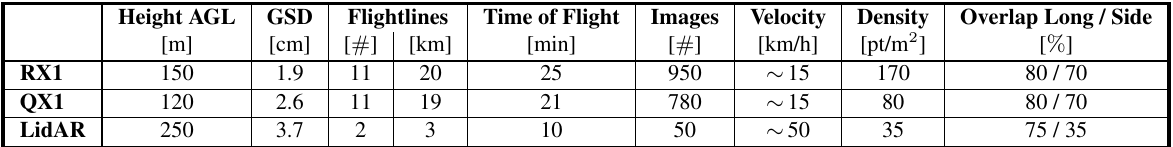
Table 2: Flight parameters for the compared cameras (Sony RX1 et QX1) and the reference LiDAR sensor: (AGL: Above Ground Level, GSD: Ground Sampling